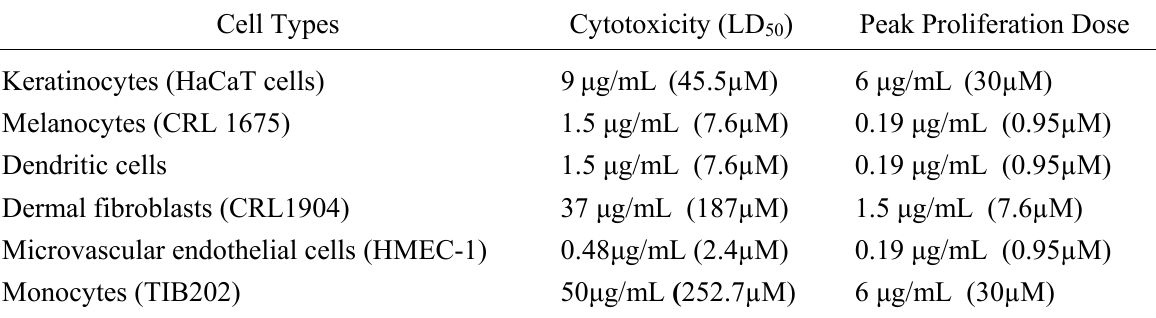
Table1. Cytotoxic and proliferation-related doses of arsenic trioxide in various cell